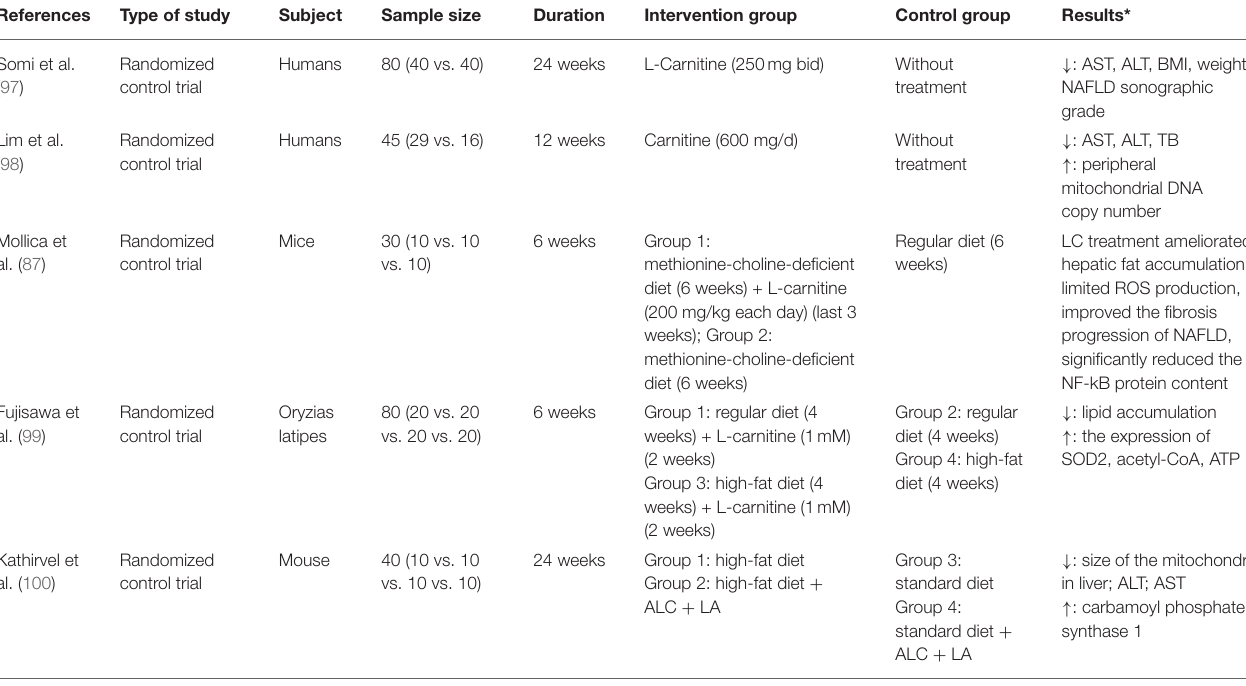
TABLE 1 | Studies reporting the outcomes of L-carnitine supplementation on